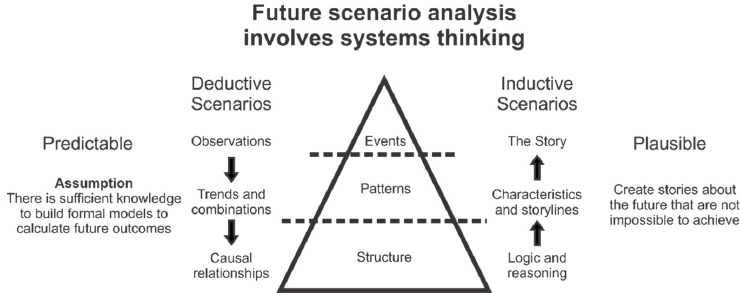
Figure 6. Quantitative (deductive) versus qualitative (inductive) scenario analyses.